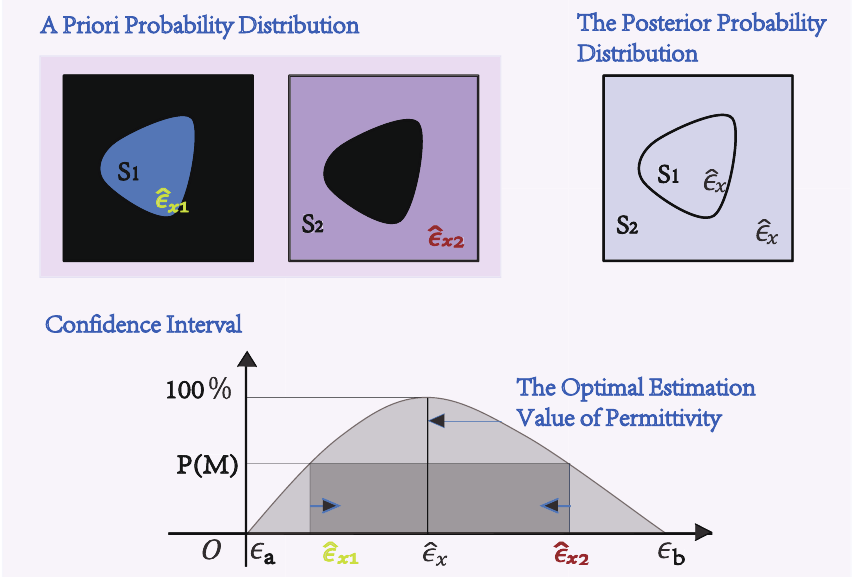
Figure 2. Distributions of PDFs for a priori probability, the posterior probability, and confidence interval,